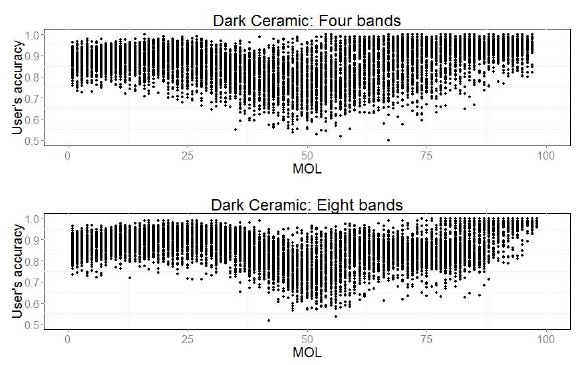
Figure 6. D ARK CERAMIC user’s accuracy × MOL for each iteration.